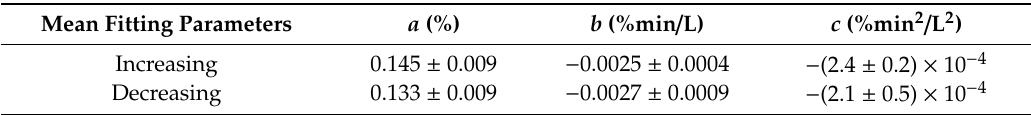
Table 1. Polynomial second-order fitting parameters of the sensor response (mean values and standard